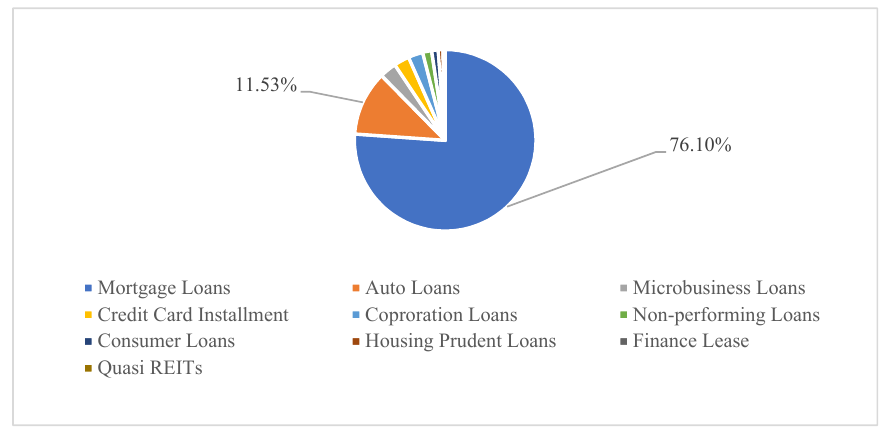
Figure 12. The composition of ABS in 2020 and their proportion. Source: Wind Database. With the guideline “houses are for accommodation, not for speculation” by China’s central government, the housing financialization process started to be strictly restricted and evidently slowed down, since the year 2017. Since the year of 2021, peering into the abyss of debts default across the industry, real estate developers started lowering their leverage, or in the other word, de-financialization process [64]. The average leverage ratio dropped from over 80% at the peak time in 2019 to 78.9% in 2022. Moreover, the proportion of real estate sector in new RMB loans in financial institutions has reduced from 44.8% at the peak time in 2017 to 26.3% in 2021. Developers reject borrowing to expand their reinvestment and narrow their debts due to their balance sheet deflation.